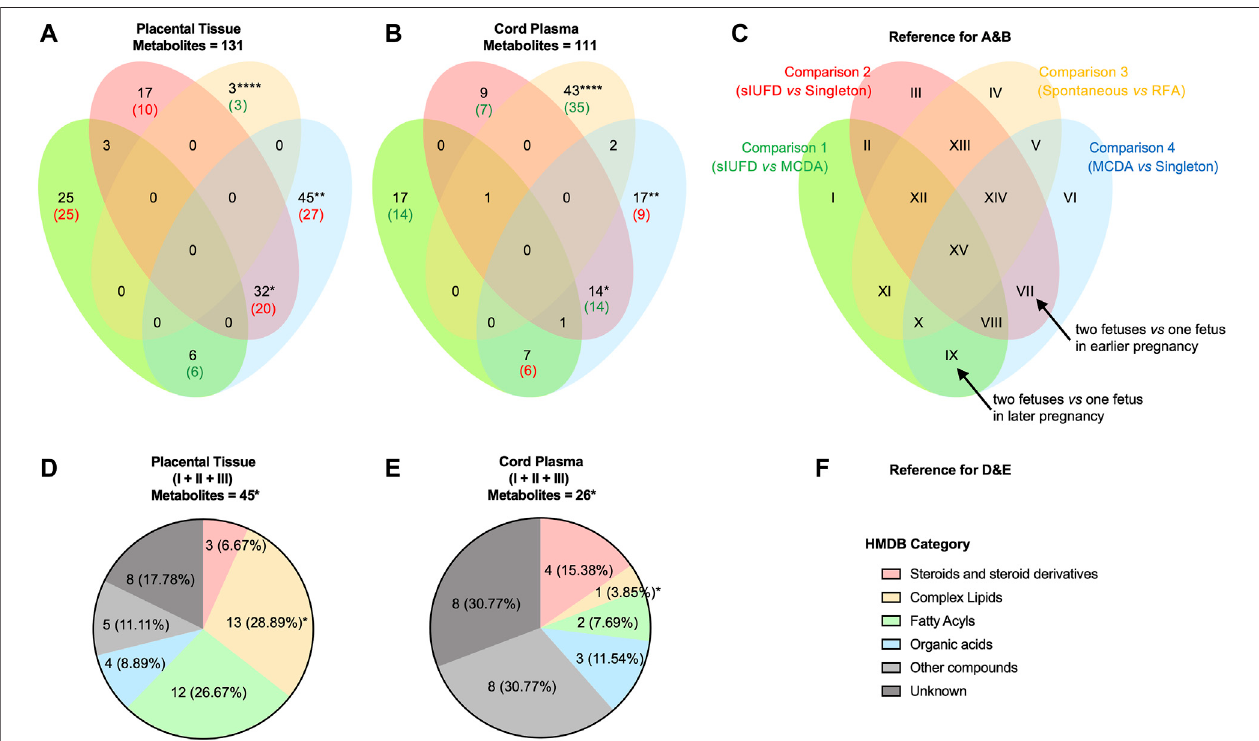
FIGURE 2 | Metabolic differences between placental tissue and cord plasma. Venn diagrams show the overlap in differential metabolites identi fi ed from comparisons made in placental tissue (A) and in cord plasma (B) , and the data represent the number of metabolites: the total number is shown in black; the main expression trendisshowneitherinred(upregulated) oringreen(downregulated). (C) ThereferenceforAandB.Thefourcomparisonsarerepresentedasfourellipsesin their iconic colors, which are C1: in green, (RFA + Spontaneous) vs. MCDA; C2: in red, (RFA + Spontaneous) vs. Singleton; C3: in orange, Spontaneous vs. RFA; andC4:inblue,MCDAvs.Singleton.Thus,differentialmetabolitesmaypresentin15regions(fromItoXV).Tobetterunderstandtheexpressiontrend,therepresentative meaning after logical reasoning oftwo regions are noted (arrow): VII (C4+C2): two fetuses vs . one fetus in earlier pregnancy; and IX (C4+C1): two fetuses vs . one fetus in laterpregnancy.Piechartsillustratethecategory(accordingtotheHMDB)ofmetabolitesinregionItoregionIII(combined),inplacentaltissue (D) andincordplasma (E) , and the data represent the number (%) for compounds of each category. (F) The reference for D and E. Fisher ’ s exact test was conducted to analyze the difference between placental tissue and cord plasma. * < 0.05; ** < 0.01; *** < 0.01; **** < 0.0001. Abbreviations: MCDA, monochorionic diamniotic; sIUFD, single intrauterine fetal death; RFA, radiofrequency